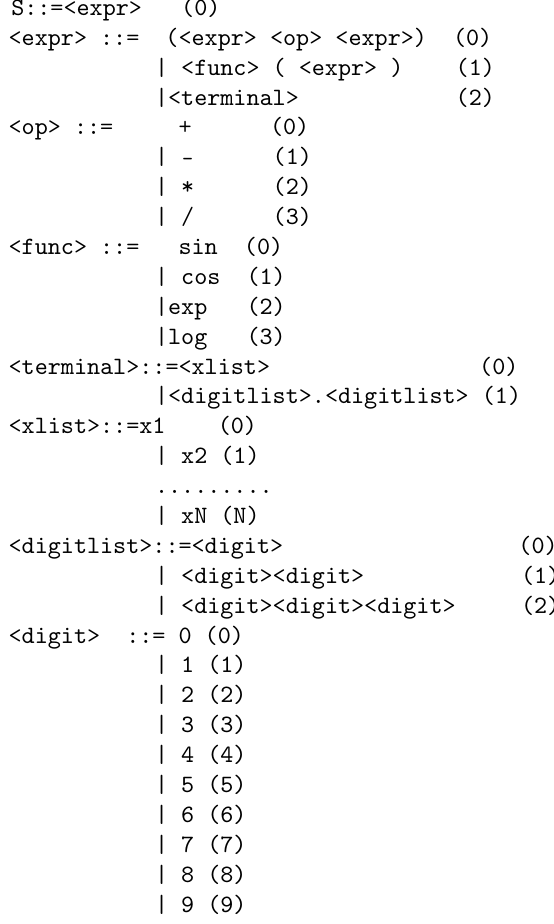
Figure 1. BNF grammar of the proposed